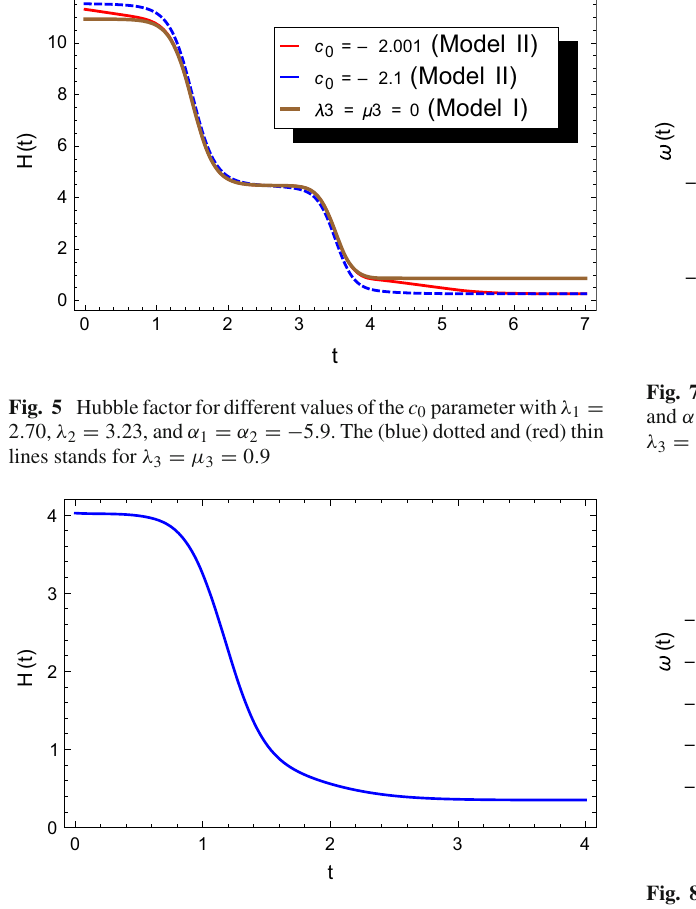
Fig. 6 Hubble factor for Model III , with c 0 = 1 . 00015, λ 1 = 2 . 25, λ = 4 . 5, λ = 0 . 00005, and α = − 7 . 02 2 3 3